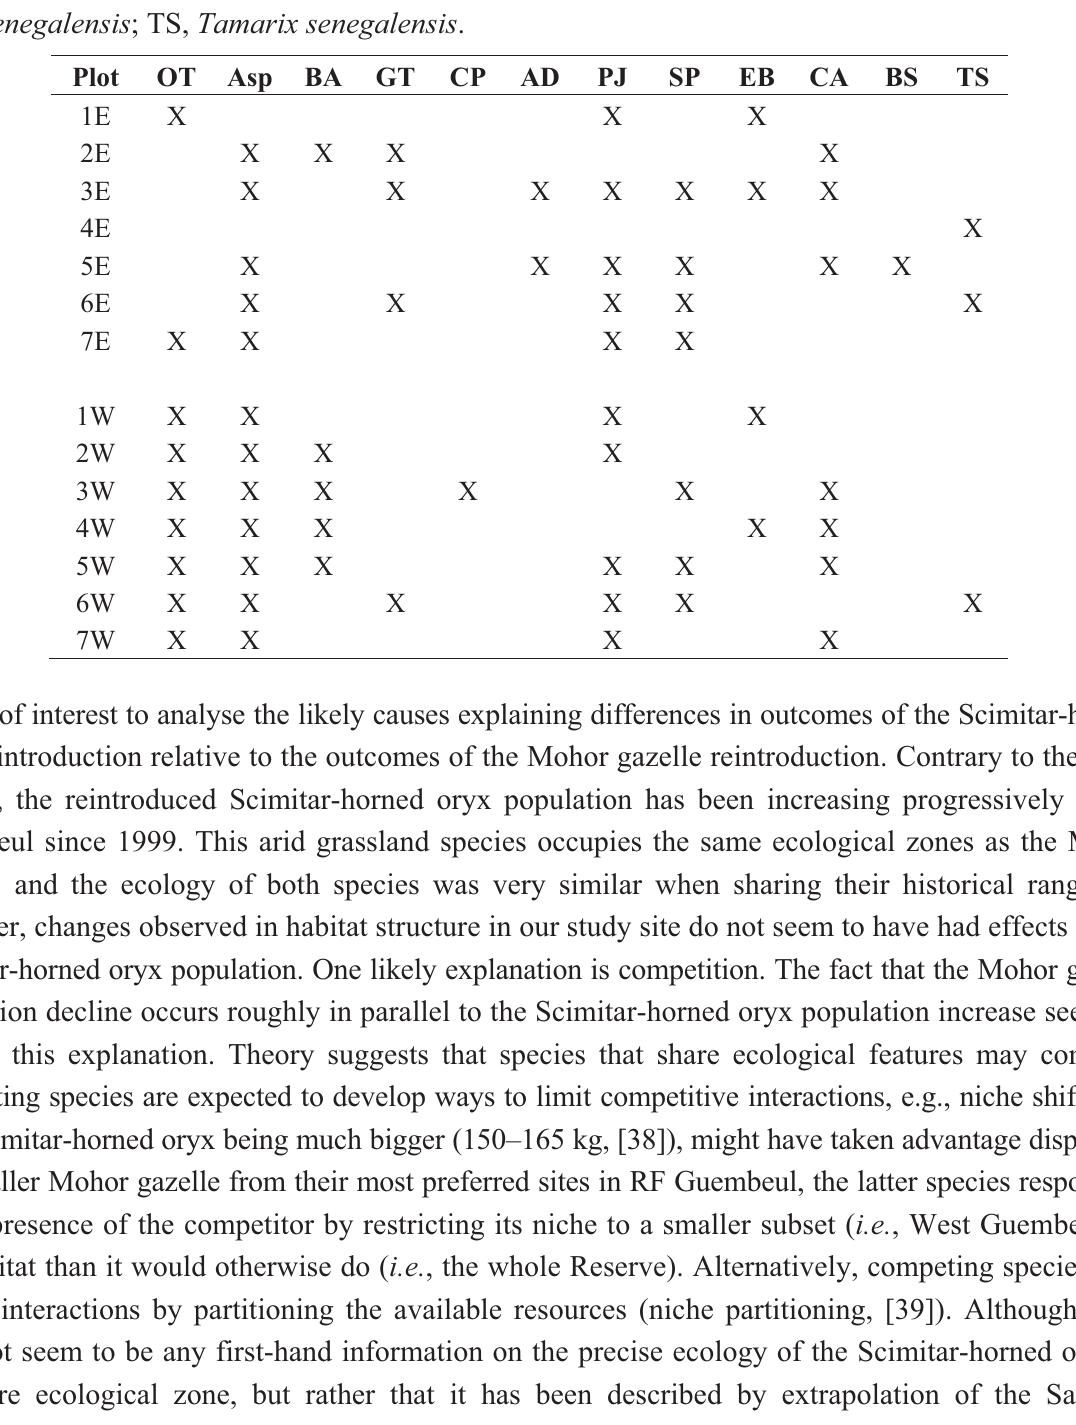
Table 3. Main tree and thorn-bush species found within the sampled plots. Plots are coded as in Figure 1 (1E–7E, eastern part of RF Guembeul; 1W–7W western